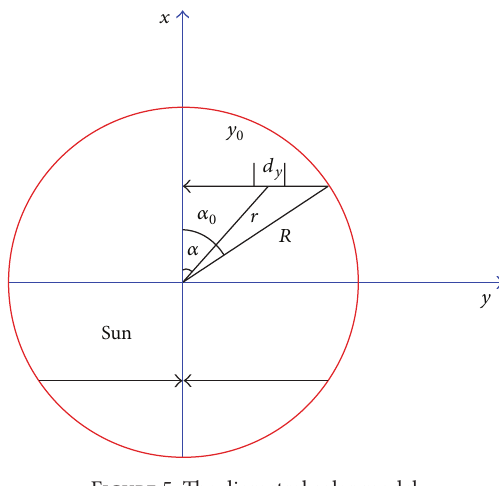
Figure 5: The diametral solar